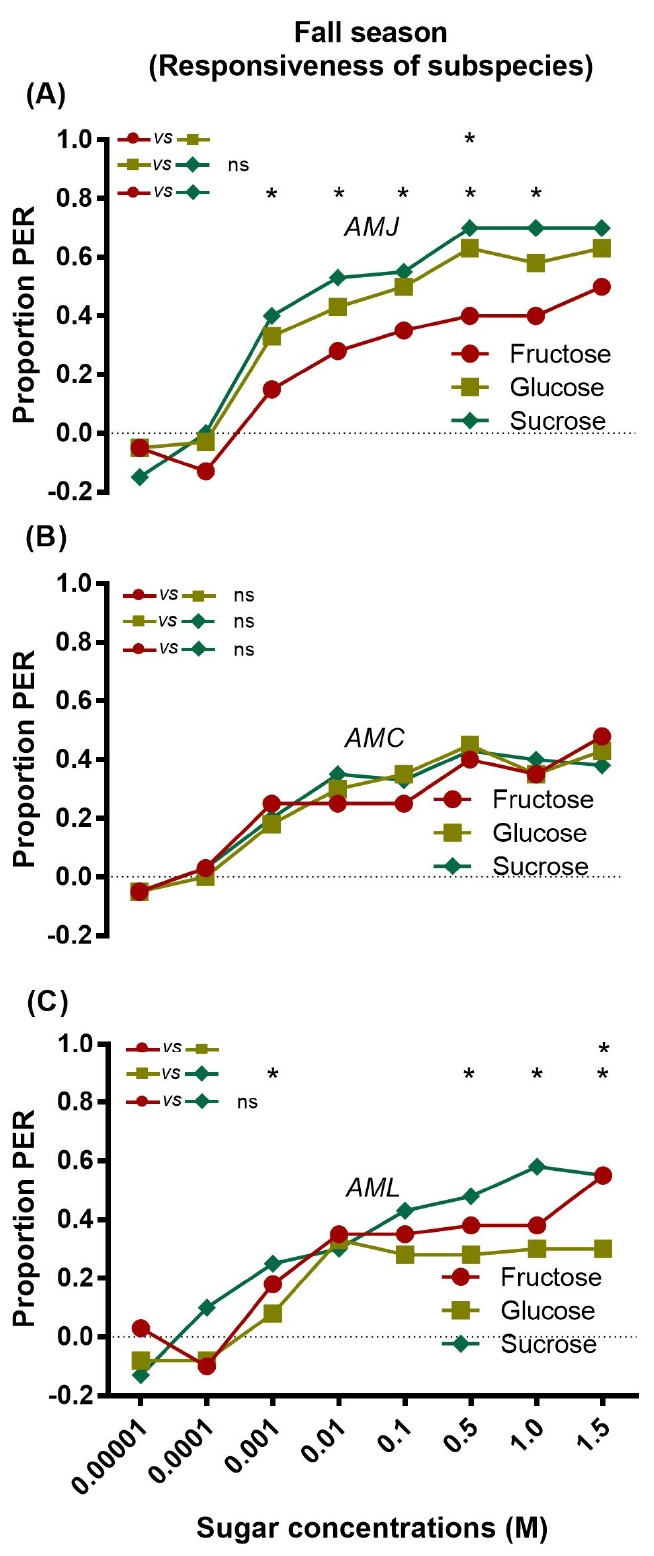
Figure 4. Sugar responsiveness of single honey bee subspecies AMJ ( A ), AMC ( B ) and AML ( C ) to fructose, glucose, and sucrose during the fall season. Asterisks indicate the significant difference ( x 2 or Fisher’s exact test * p < 0.05) for the responses of single honey bee subspecies AMJ ( A ) AMC ( B ) and AML ( C ) against different concentrations of the respective sugar (fructose vs. glucose, glucose vs. sucrose and fructose vs. sucrose).